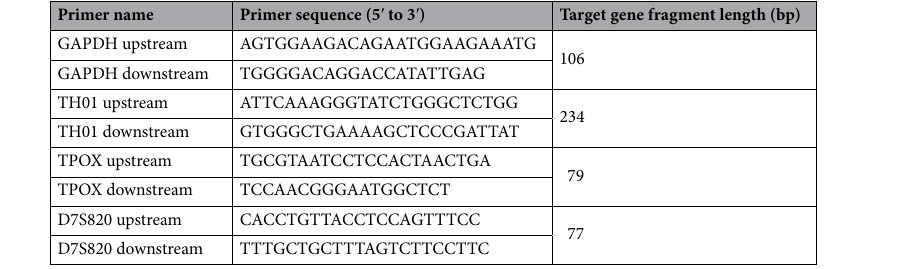
Table 1. Four target gene primer